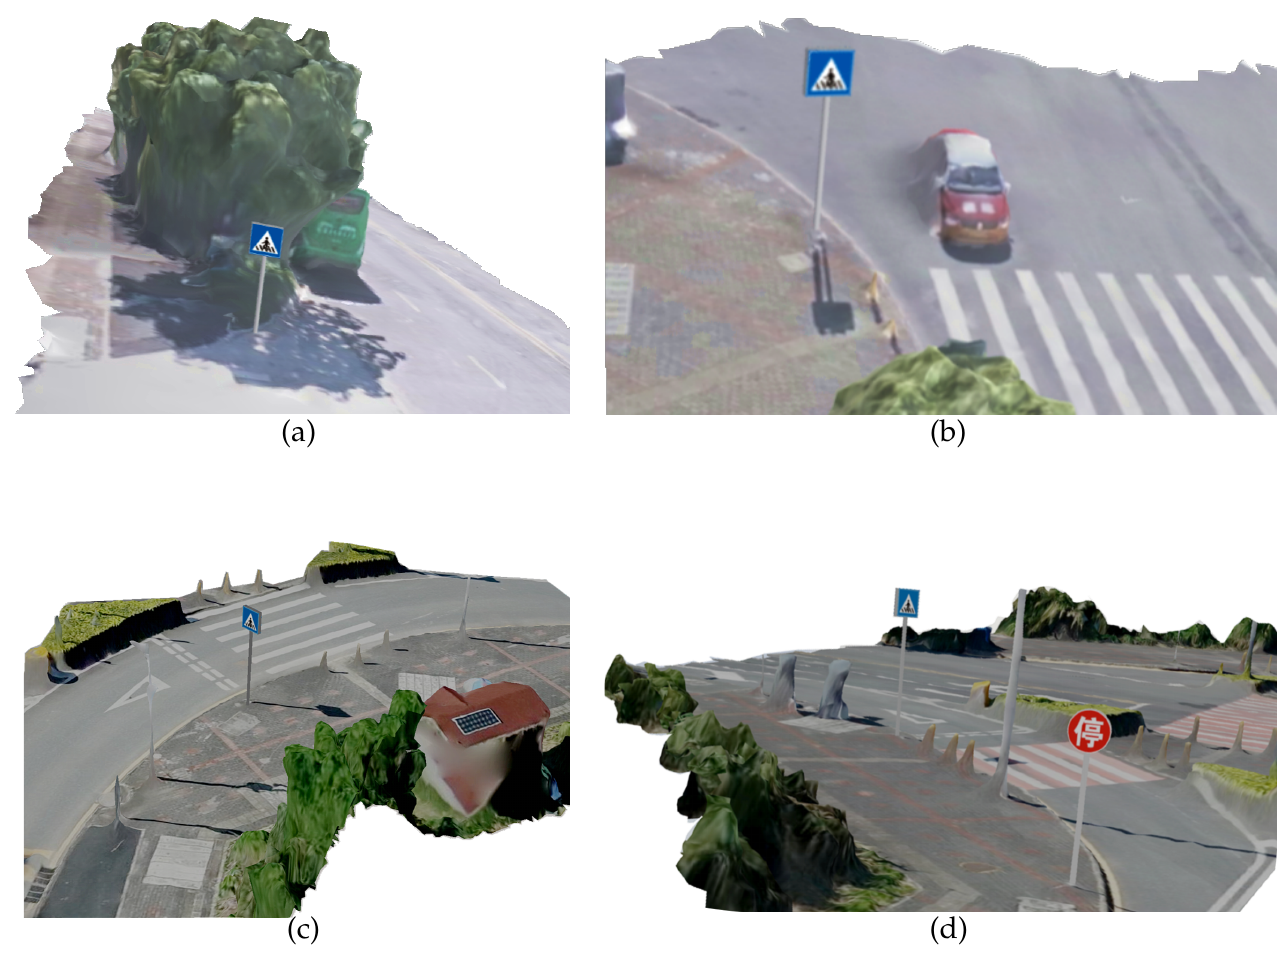
Figure 16. Several cases of road sign embedded modeling results. Figure 16. ( a – d ) Several cases of road sign embedded modeling